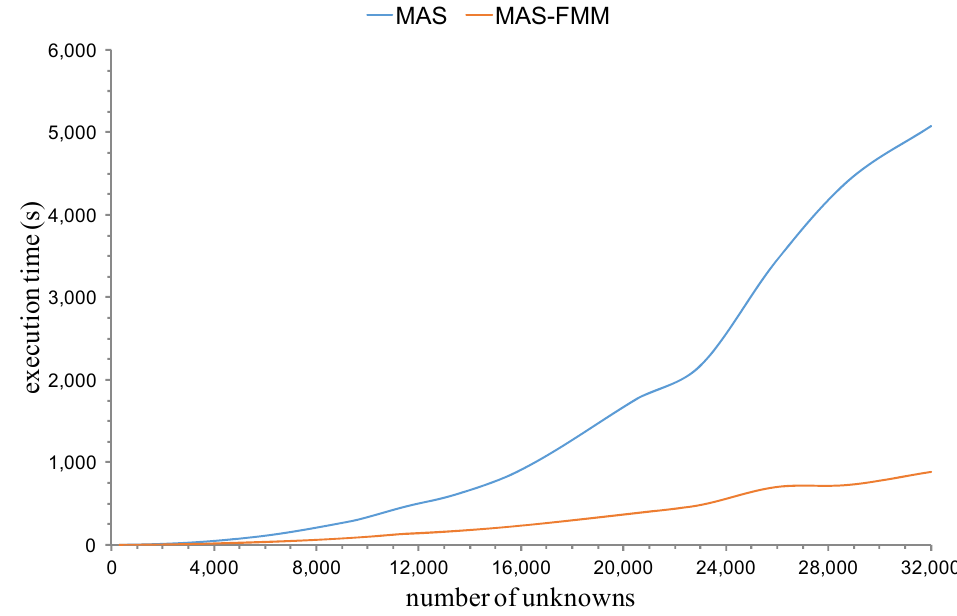
Figure 6. Execution times required by the MAS and MAS-FMM schemes for forming and solving the linear system for the MAS currents as a function of the (total) number of unknowns. The results correspond to lattices of increasing size up to 20 × 20. The number of unknowns in the horizontal axis changes as an outcome of the increase in the number of cylinders in the lattice. The number of auxiliary sources per cylinder remained unaltered.